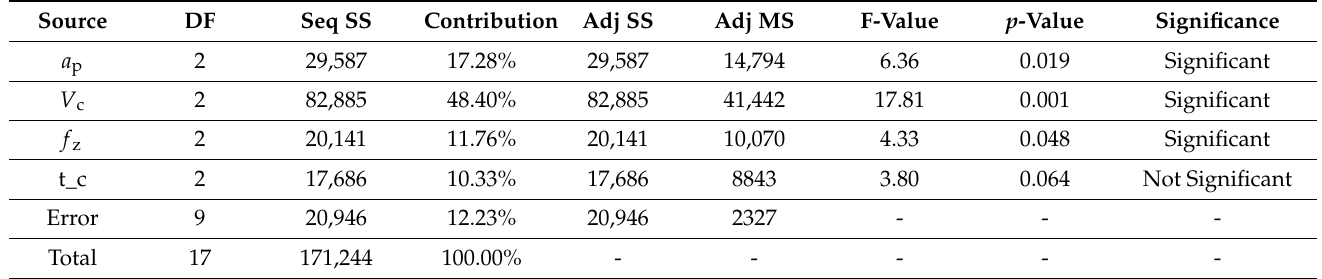
Table 8. Analysis of Variance (ANOVA) for surface roughness.